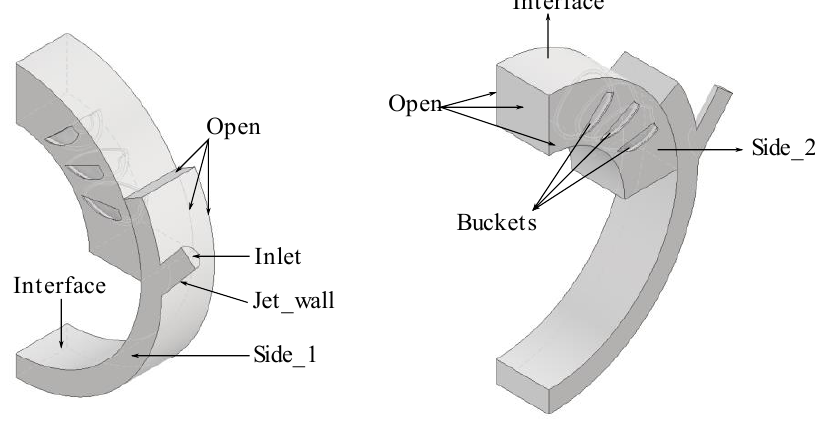
Figure 6. Computational Domain of Pelton Turbine.